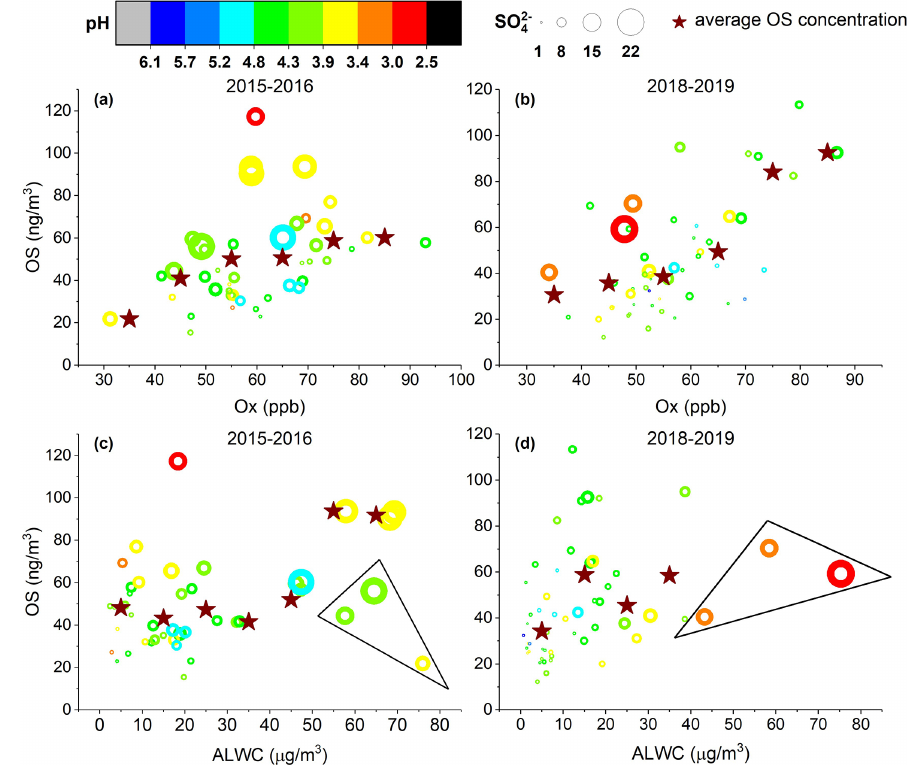
Figure 5. Quantified OS concentrations as a function of (a, b) the level of O x (O x = O 3 + NO 2 ) and (c, d) aerosol liquid water content (ALWC) in 2015–2016 and 2018–2019, except for summer. The circles are colored according to the aerosol pH and their size is linearly scaled with the SO 2 − concentration. The markers inside the triangle indicate the observations with low O x levels ( < 50ppb). The measured 4 OS concentrations within regular O x or ALWC intervals (every 10 unit lengths) were averaged to more obviously demonstrate the trend (star